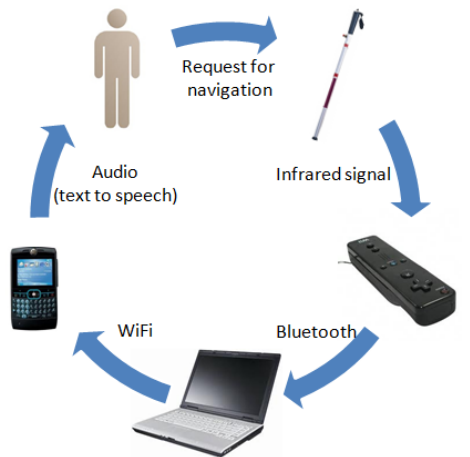
Figure 1. Components of the navigation